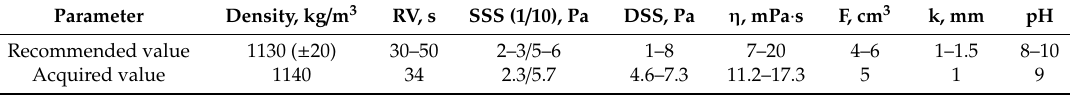
Table 6. Technological properties of developed composition of the drilling